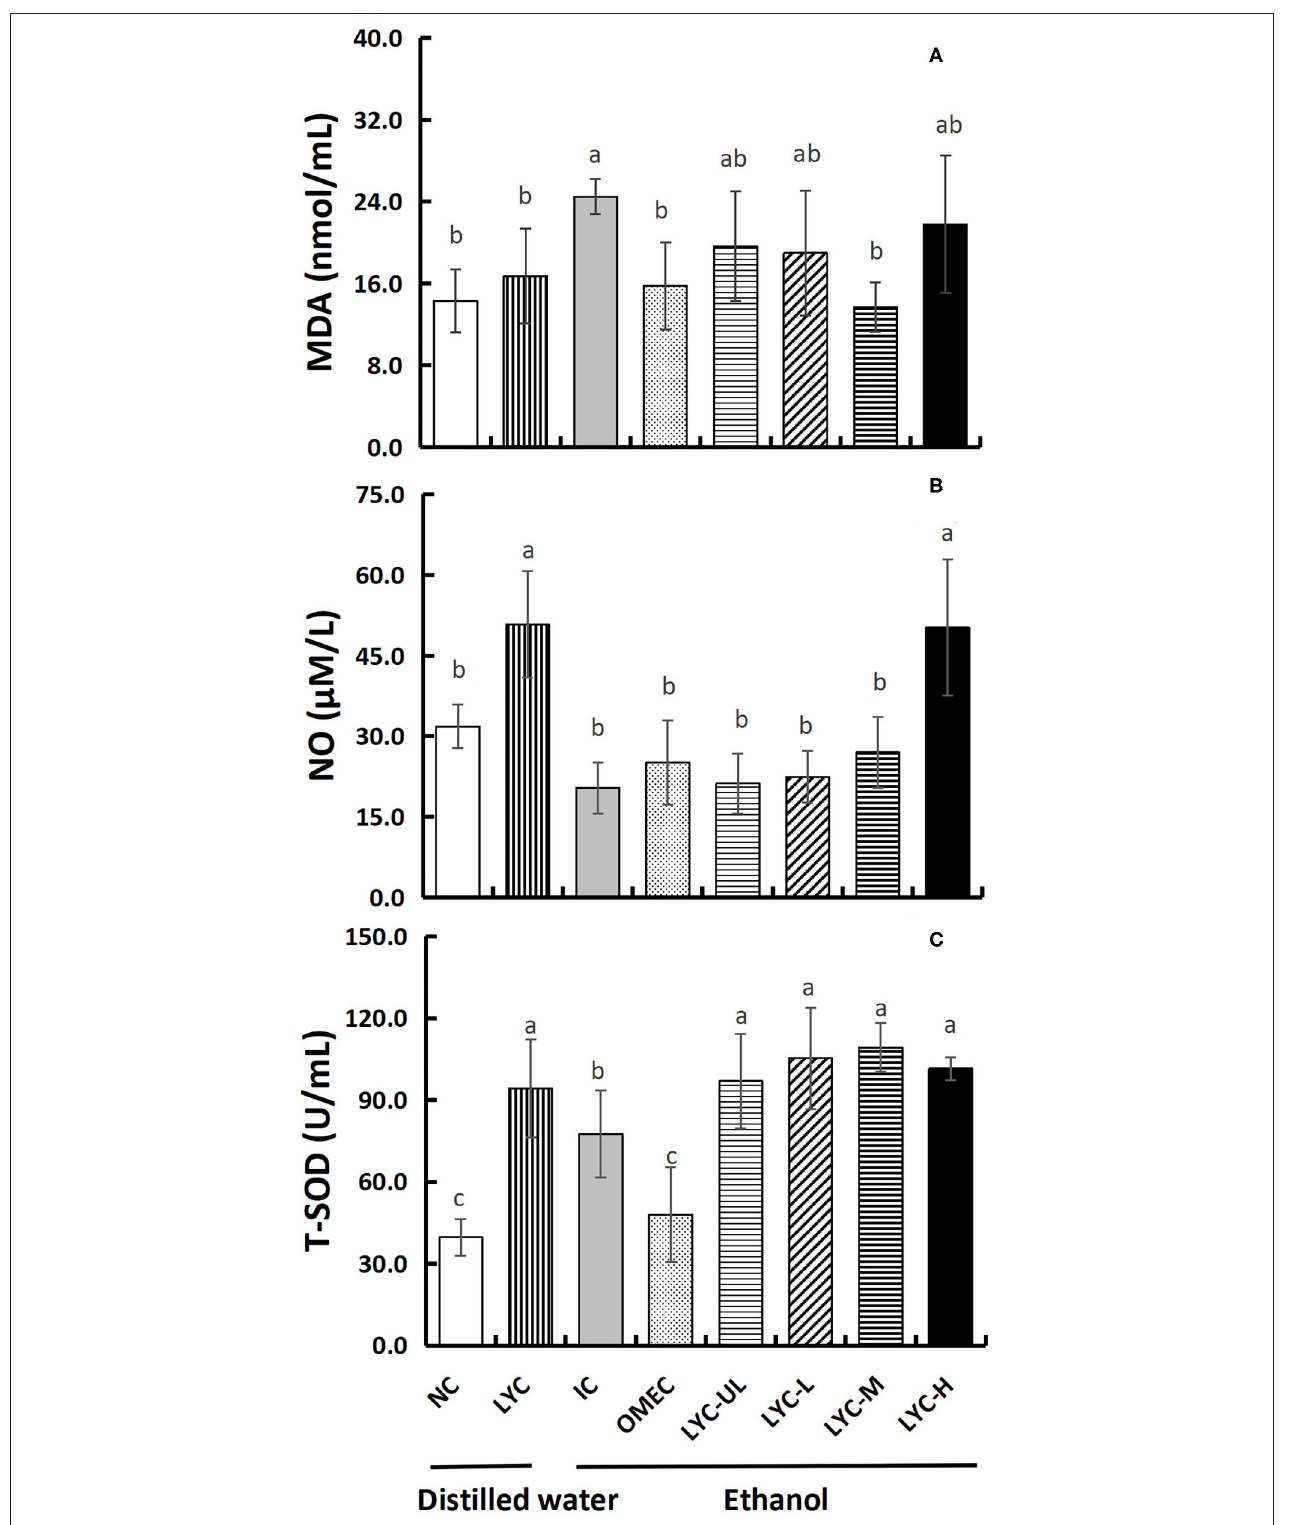
FIGURE 4 | Effect of lycopene on antioxidant factors of serum. NC, normal control group; LYC, lycopene control group; IC, injury control group; OMEC, omeprazole control group; LYC-UL, ultralow-dose group; LYC-L, lycopene low-dose group; LYC-M, lycopene medium-dose group; LYC-H, lycopene high dose group. (A) Malonaldehyde (MDA). (B) Nitric oxide (NO). (C) Total superoxide disumutase (T-SOD). Values are means standard deviation of 14 mice and triplicate measurements. Different letters indicate significant differences ( P < 0.05) between different groups.